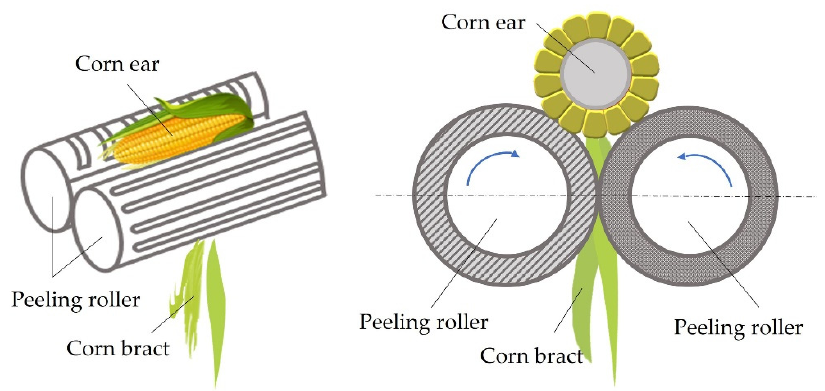
Figure 1. Schematic diagram of mechanical corn peeling.